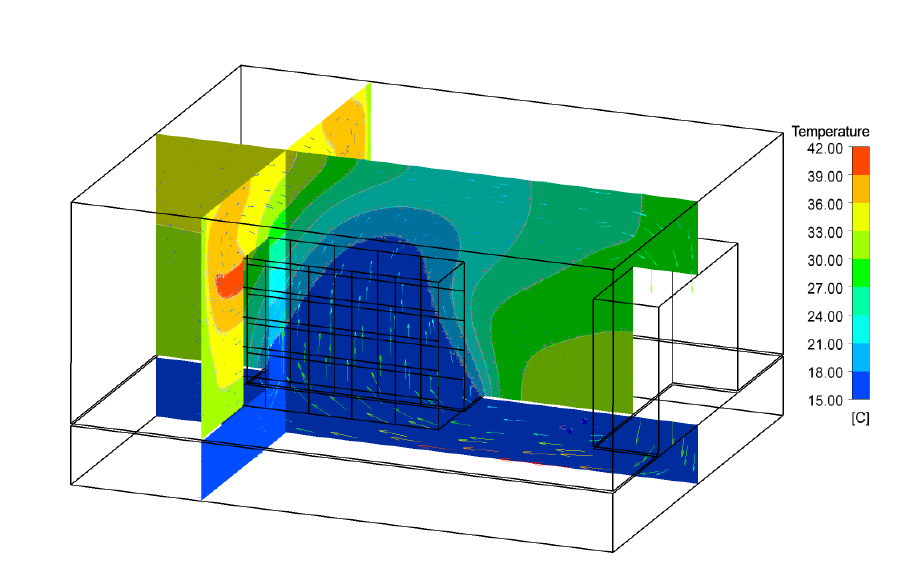
Figure 4. Data center layout used in our study.